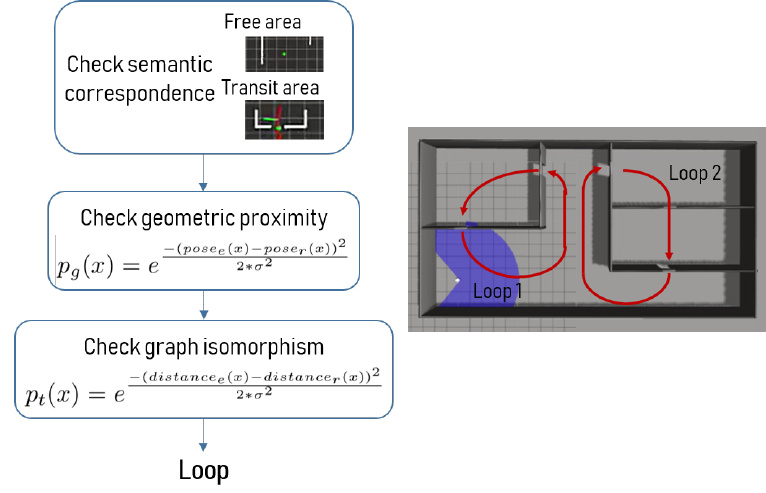
Figure 9. Simulated environment with two loop situations: one connecting two rooms and the other one connecting three